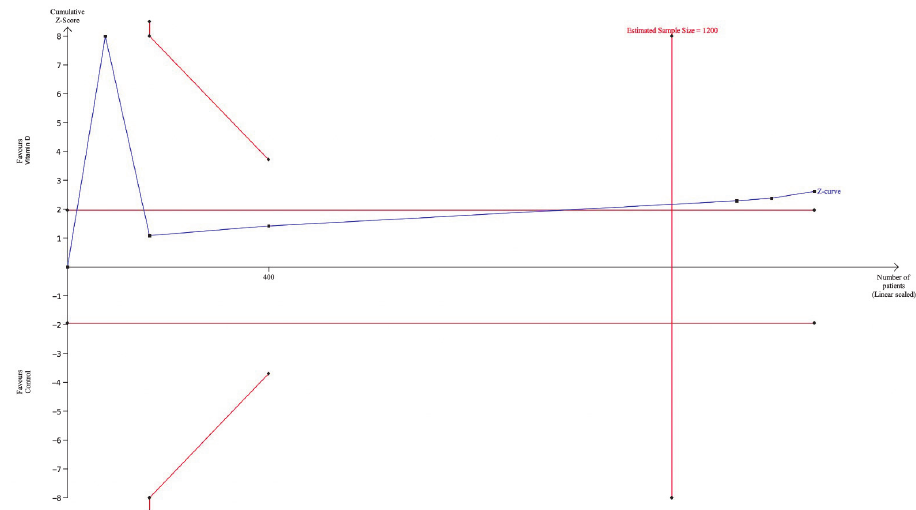
Figure 4. Trial sequential analysis of the positive association of protective effect of vitamin D supplementation with intensive care unit admission in patients hospitalized with COVID-19. The cumulative z-curve crosses the trial sequential alpha boundary, suggesting that the positive result is conclusive.